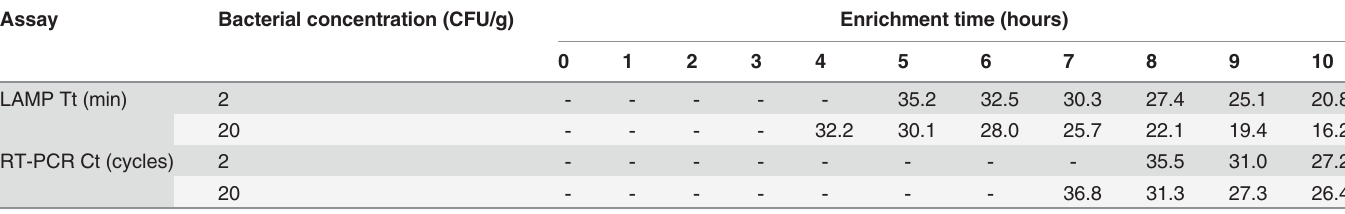
Table 3. A comparison of the STY2879-LAMP and RT-PCR assays in the human stool samples spiked with two low levels of S . Typhi. Assay Bacterial concentration (CFU/g)